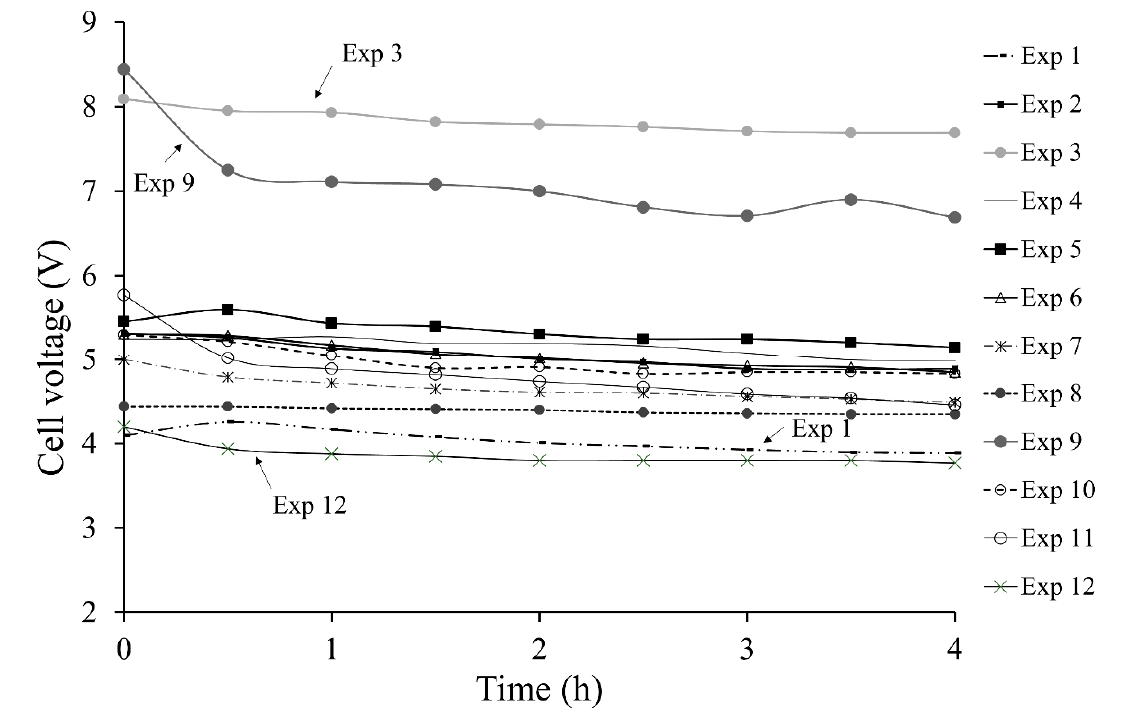
Figure 4. Cell voltage versus time for each experiment.